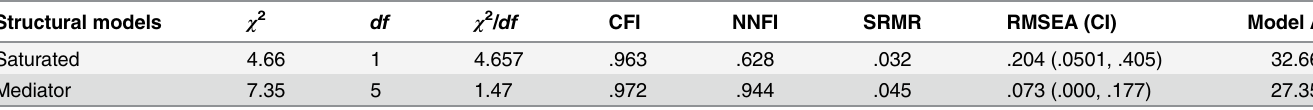
Table 1. Goodness-of-fit Indicators for the Mediation Models ( N = 89).